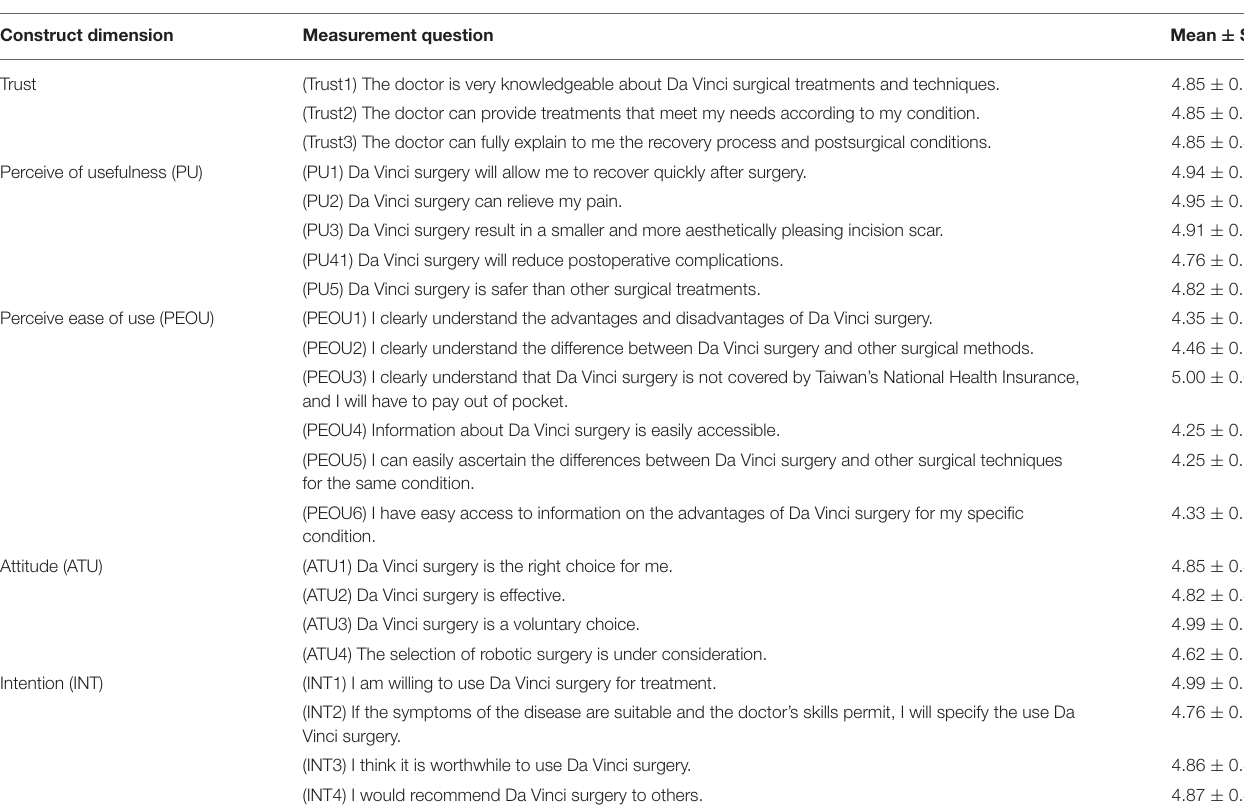
TABLE 2 | Mean and standard deviation for measurement items. Construct